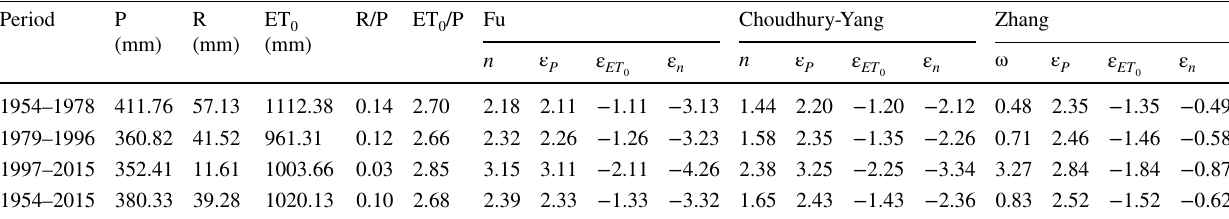
Table 4 Statistics in hydro-meteorological variables of the Huangfuchuan River basin Period P